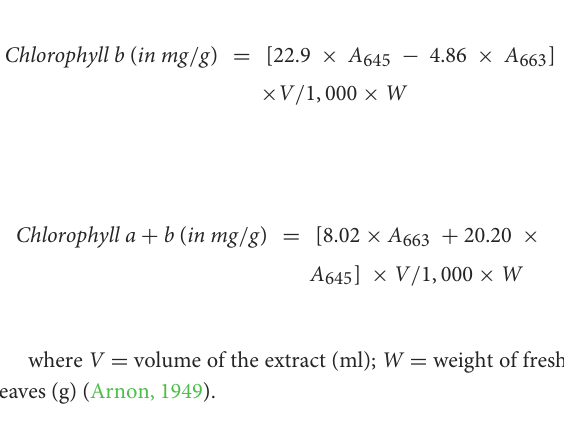
chlorophylls degrade under light conditions). The supernatant was transferred to a fresh centrifuge tube and stored in the dark after centrifuging the tube at 4 ◦ C for 15 min at 3,000